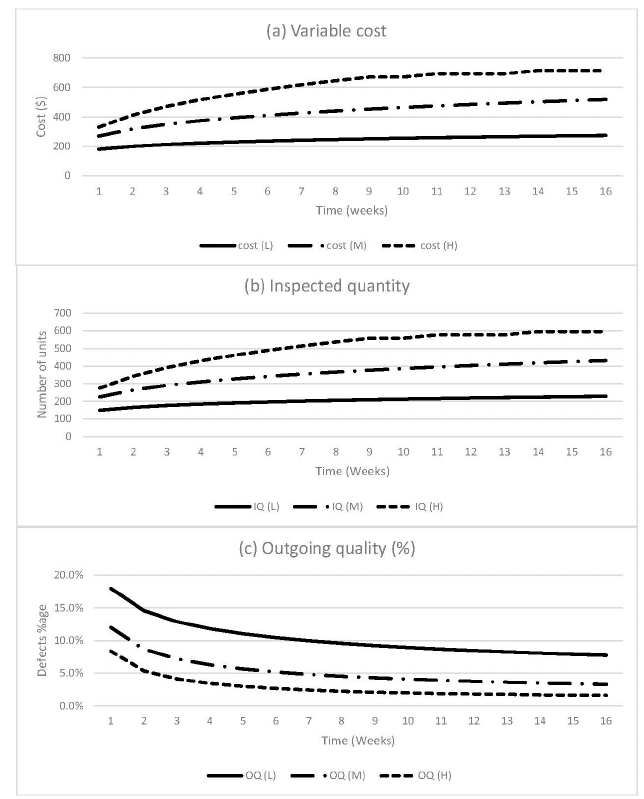
Figure 2. Influence of learning behavior on inspection performance of different inspectors.